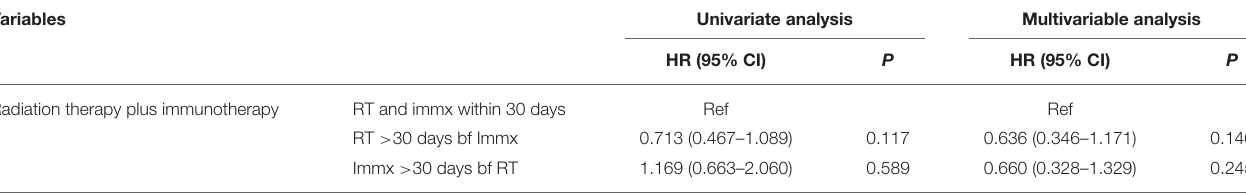
TABLE 6 | Univariate and multivariable cox analysis of the sequence of radiation therapy and immunotherapy.